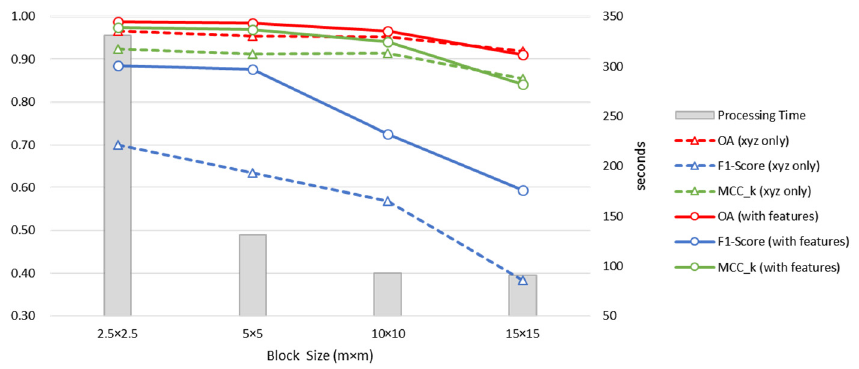
Figure 6. Classification results of PointNet on MLS point clouds with different block sizes.